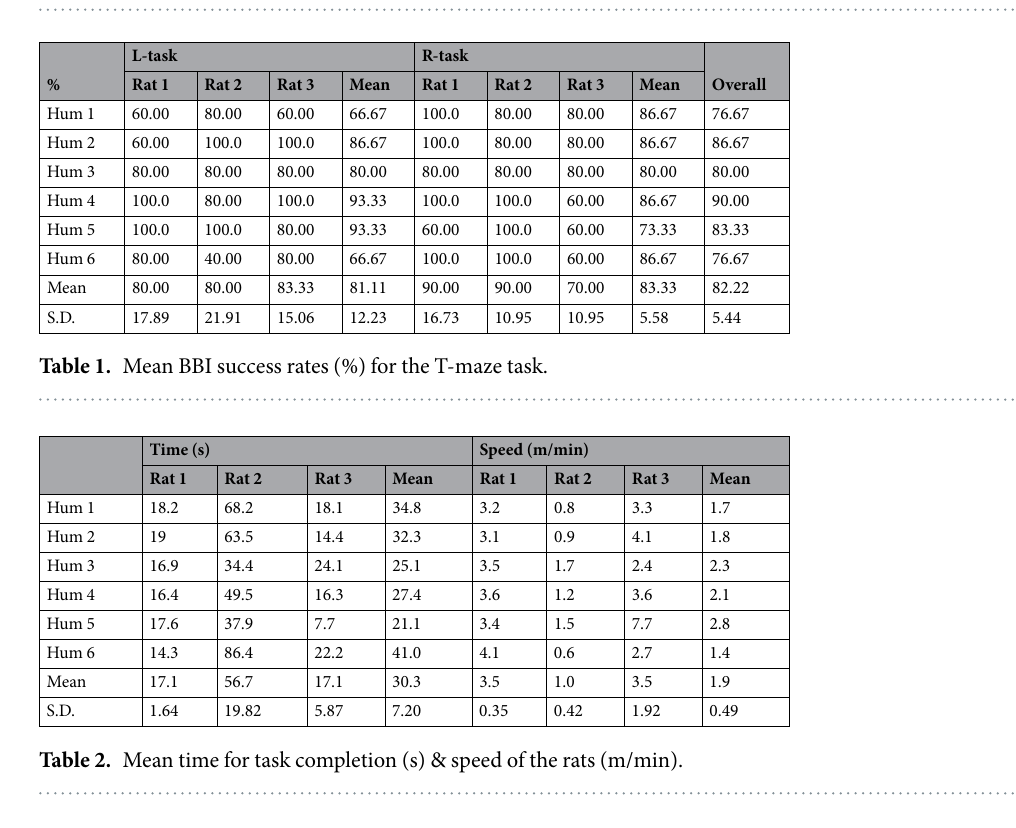
Figure 1. Schematic for the real-time rat-navigation experiment. Each experimental trial comprised a preparation phase and a task phase. In the preparation phase, experimenters set the system parameters, placed the rat at the start position, and checked the readiness of the human participant. The task phase began by flickering two directional arrows at different frequencies, displaying a live webcam image with a visual cue to the human participant, and opening the door of the maze. During the task phase, the human participant was required to move the rat to the goal, as determined by the visual cue. A trial ended when the rat arrived at one of the three ends of the maze (left, right, or the start position) after traversing the intersection.